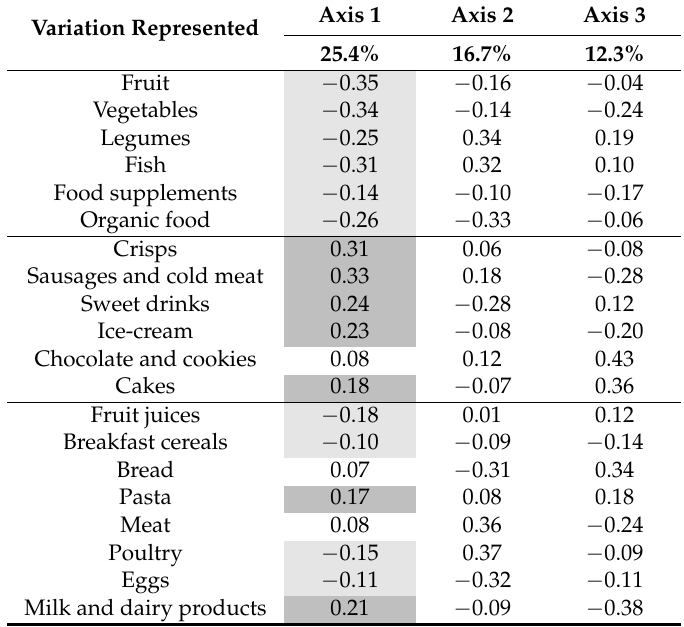
Table 3. Loadings of each food type on the first three axes of a principal components analysis (PCA) based on a correlation matrix of sales percentages. The fraction of variation represented by each PCA axis is given in the first row. For the first PCA axis, light-grey shading indicates food types associated with the healthy side of the sales gradient, and dark-grey shading indicates the food types associated with the unhealthy side of the sales gradient. Horizontal lines subdivide the three a priori categories (healthy, unhealthy, both/basic, cf. Table 2). Axis 1 Axis 2 Axis Variation Represented